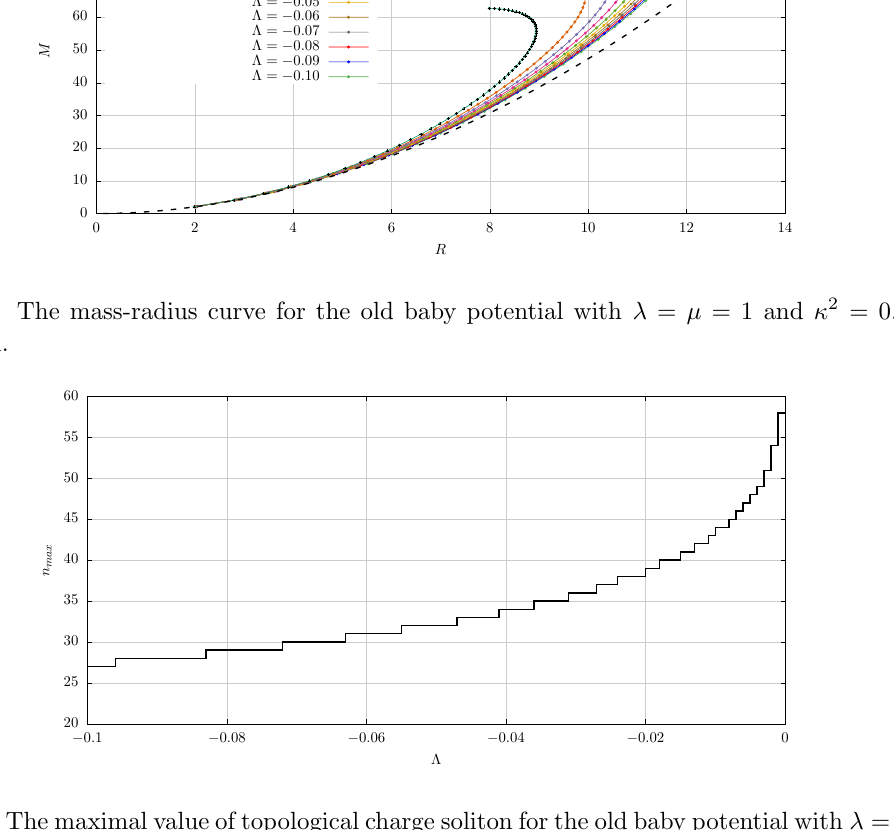
Figure 9 . The maximal value of topological charge soliton for the old baby potential with (cid:21) = (cid:22) = 1 and (cid:20) 2 = 0 : 1, for di(cid:11)erent